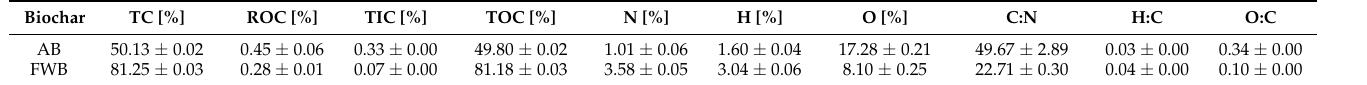
Table 1. Physico-chemical properties of used biochars in this